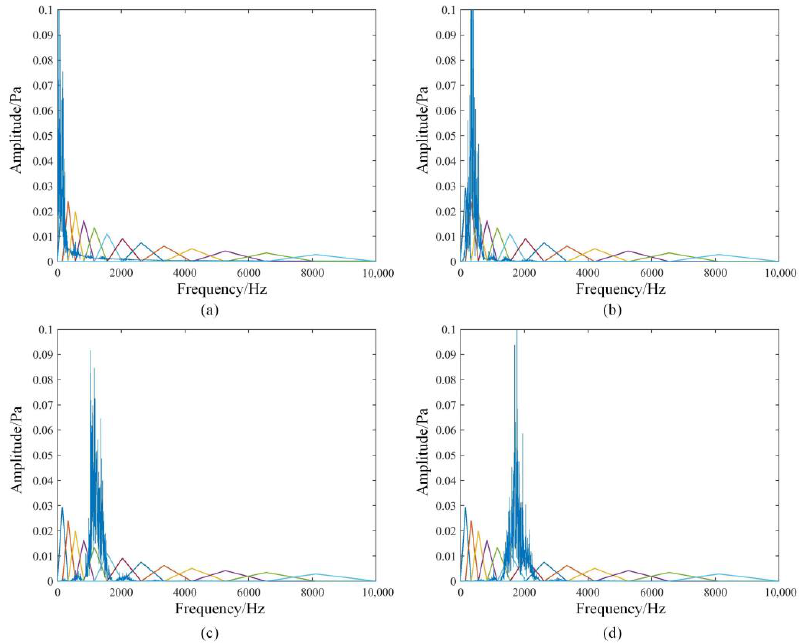
Table 5. Indexes related to the energy proportion of each IMF component.